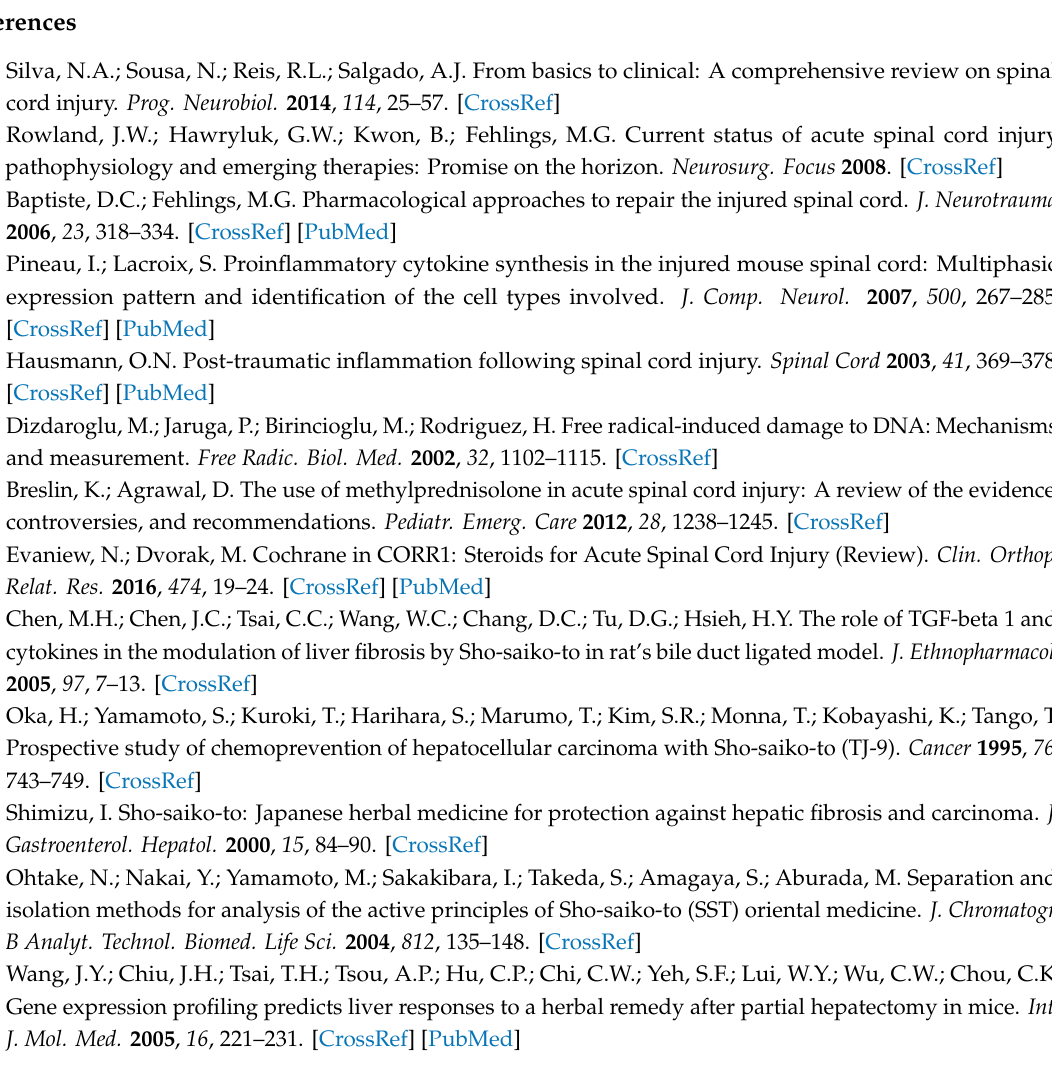
Figure S3: E ff ects of S / B remedy on the hindlimb functions of spinal cord injured